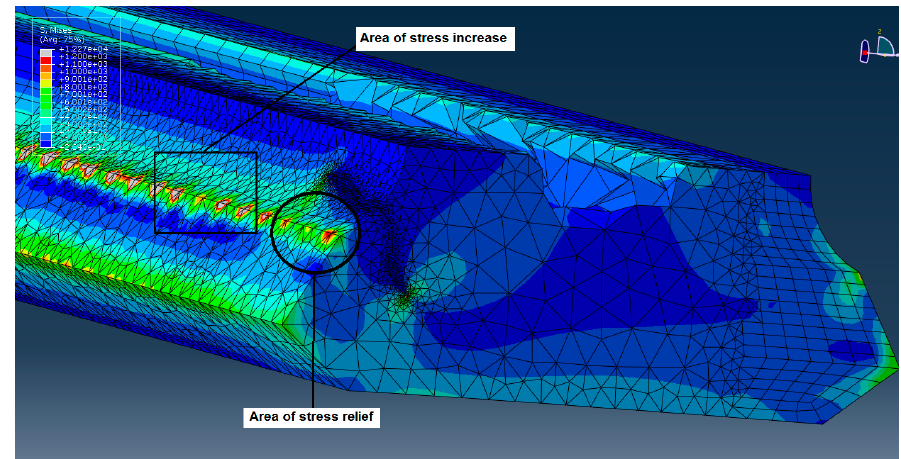
Figure 30. Contact flank stress re-distribution as a function of the crack progression.